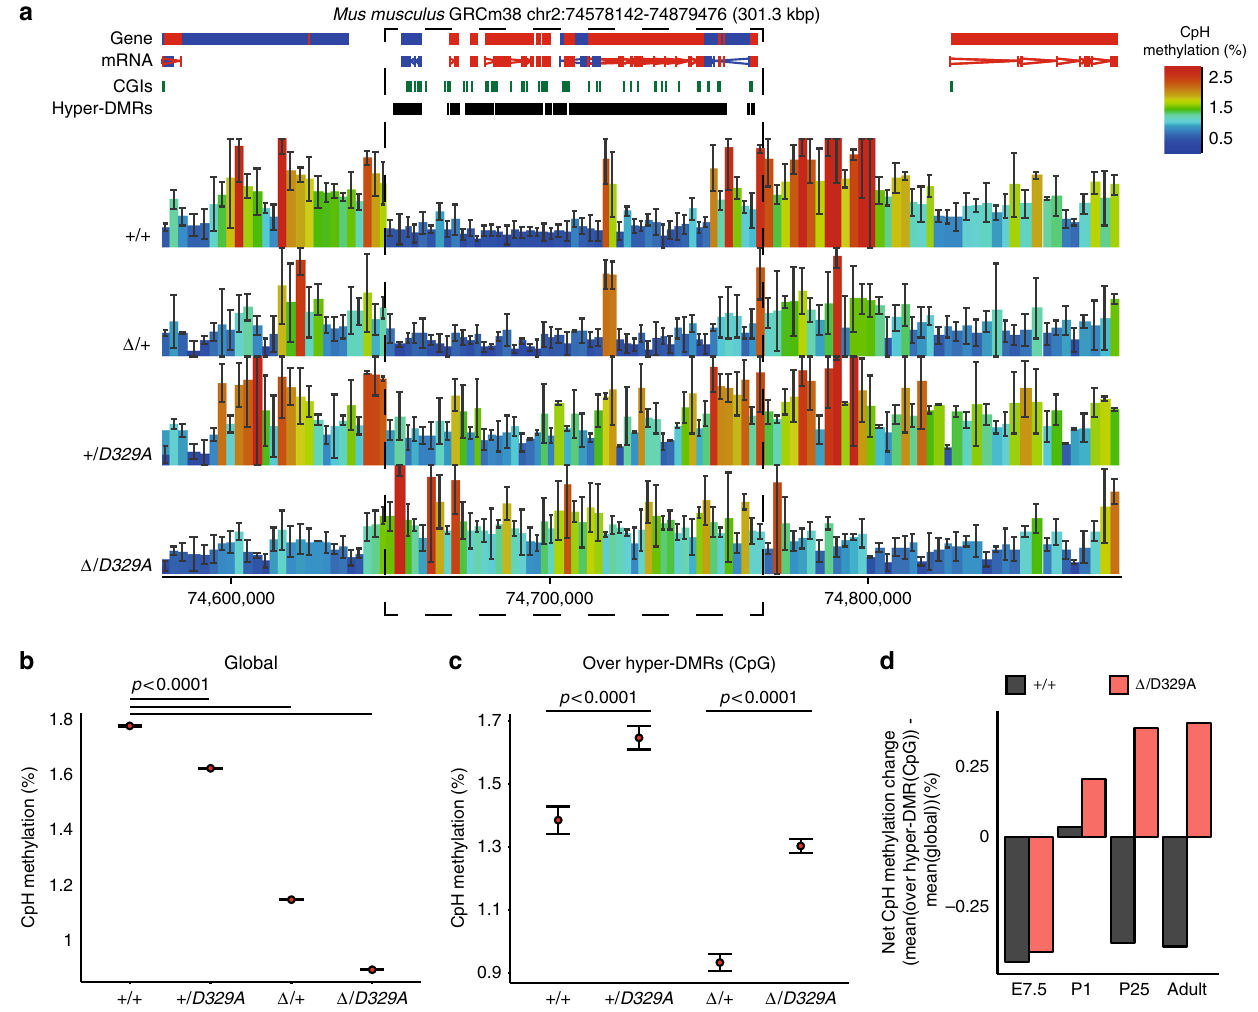
Fig. 8 CpH methylation in hypothalamus of Dnmt3a + / + and Dnmt3a Δ /D329A mice. a Representative genome browser view of CpH methylation in adult (14- week) male hypothalamus. Methylation levels appear to be dependent on the number of alleles present, with a decrease observed in Dnmt3a Δ / + compared to Dnmt3a + / + . Notably, there is an increase of methylation over hyper-DMR regions (highlighted by the box) in the presence of Dnmt3a D329A . Each bar represents a 1000-CpH tile. For gene and mRNA tracks, the colour indicates direction, where red is a forward strand and blue is a reverse strand. CGI: CpG island, hyper-DMR: hypermethylated region. n ( + / + , Δ / + , Δ /D329A ) = 3, n ( + /D329A ) = 2. Error bars indicate standard deviation. b Global mean CpH methylation values across different genotypes. c Mean CpH methylation values over DMRs with CpG hypermethylation. b , c 1000-CpH tile quantitation for chromosomes 2 and 11 was used as representative. Error bars indicate standard error of the mean. Pairwise comparisons were done using a two-tailed t -test. Raw data are provided in Source Data. d Barplot indicating the net difference in mean CpH methylation between hyper-DMRs and global levels for Dnmt3a + / + and Dnmt3a Δ /D329A mice across development (E7.5 epiblast, P1, P25, and adult hypothalamus). Raw data are provided in Source (France) by targeting in C57BL/6 ES cells. Brie fl y, a point mutation GAT to GCT resulting in aspartic acid to alanine amino acid change at the endogenous locus of Dnmt3a codon 329 was introduced (Fig. 1a and Supplementary Fig. 1). Targeting documentation is available upon request. These mice were subse- quently inter-crossed with C57BL/6Babr mice carrying a conditional Dnmt3a deletion allele Dnmt3a fl and oocyte-speci fi c Zp3 promoter-driven Cre recom- binase 12 . In order to obtain experimental litters Dnmt3a fl − / + Zp3- Cre + ve females, which carry oocytes with a conditionally deleted Dnmt3a Δ / + allele, were crossed with Dnmt3a D329A/ + males; yielding litters with four possible genotypes Dnmt3a + / + , Dnmt3a Δ / + , Dnmt3a + /D329A , and Dnmt3a Δ /D329A (Fig. 1b). Mat- ings, con fi rmed pregnancies, litters and pup numbers were recorded, where the Dnmt3a D329A allele was passed through the maternal or paternal line in mating with wild-type C57BL/6Babr mice. Caesarean sections were performed to rescue the pups if Dnmt3a + /D329A females failed to deliver. When possible, body weights of experimental litters were recorded at 1.4, 4, 6, 8, 10, and 12 weeks and analysed using mixed-model ANOVA with post hoc pairwise comparisons using Bonferroni correction. Litters were sacri fi ced and tissues were collected at embryonic day 7.5 (E7.5), postnatal day 1 (P1), P25, and adulthood (~14 weeks old). At E7.5 ectoplacental cone (EPC) and epiblast were collected in PBS and EZ nuclear lysis buffer (Sigma), respectively.